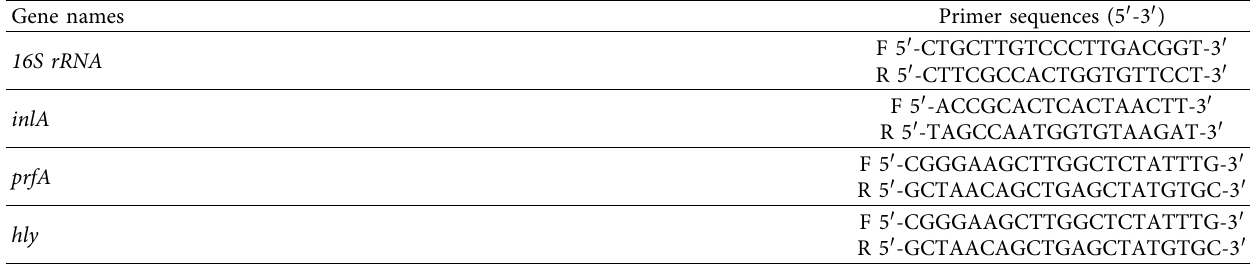
Table 2: Te sequences of the primers used to detect three virulence genes in LM.